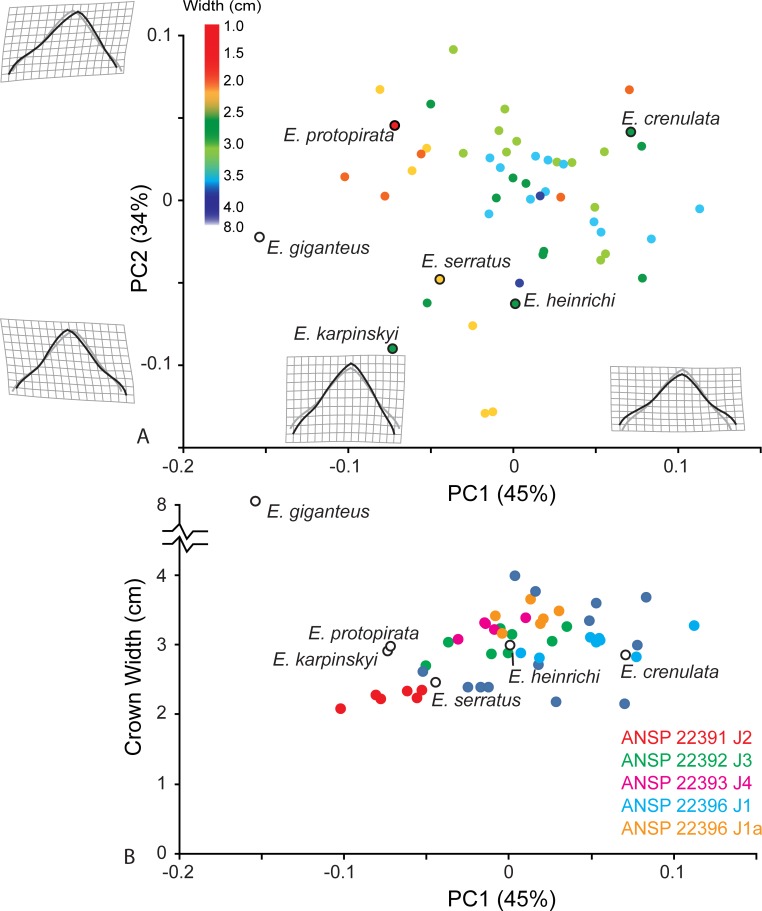
Crown dimensions for all studied Edestus specimens.Symbology corresponds to revised species designations. Holotype specimens of originally defined Edestus species have colored symbols; see Table 1 for specimen identification. Holotype abbreviations: c = E. crenulatus; g = E. giganteus; h = E. heinrichi; k = E. karpinskyi; min = E. minor; mir = E. mirus; pri = E. pringlei; s = E. serratus; t = E. triserratus; pro = E. protopirata; v = E. vorax.